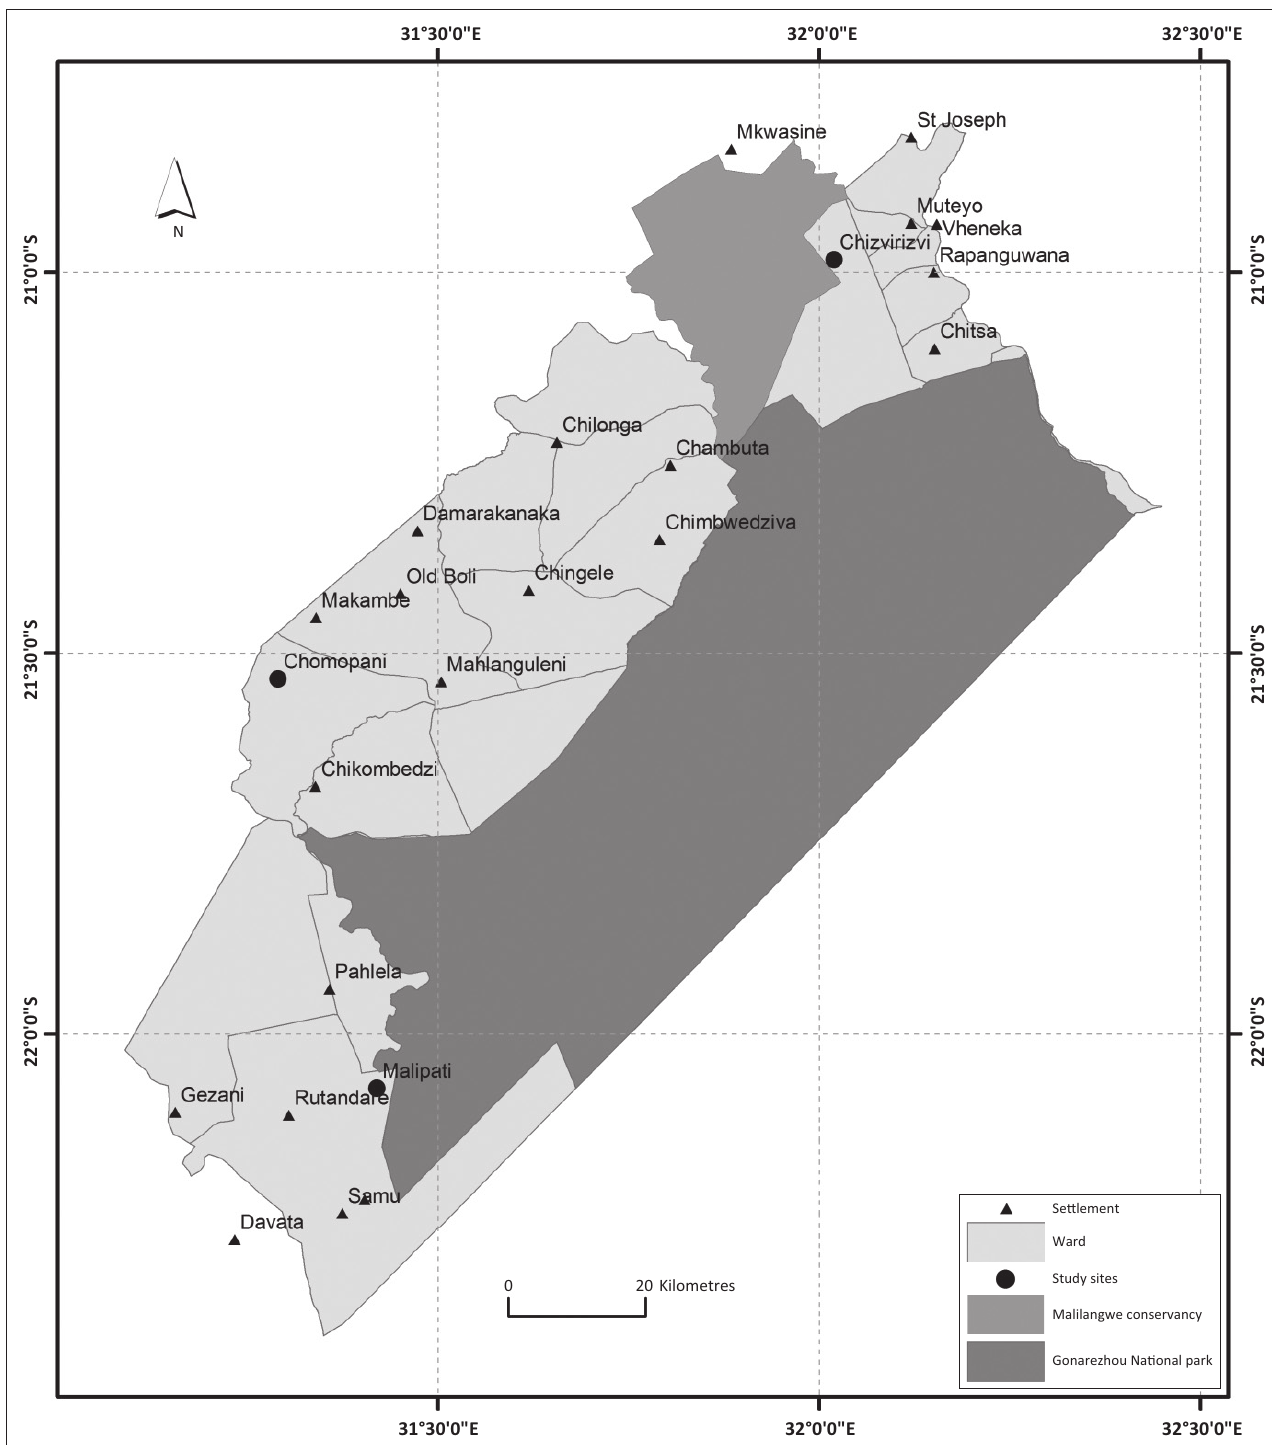
FIG URE 1: Map of the south-eastern Lowveld of Zimbabwe showing the Gonarezhou National Park and the adjacent Malilangwe Conservancy. The three studies are sites represented by big black A list of all farmers (representing households), who dip their cattle or those who are likely to use (without cattle) any of the dip tanks, is kept at the local veterinary office based in each of the areas (Ndengu et al. 2017a), this was taken as a representative household sampling frame. One dip tank was chosen for each selected study site based on its appropriate location to the interface and these were the Malipati (porous),